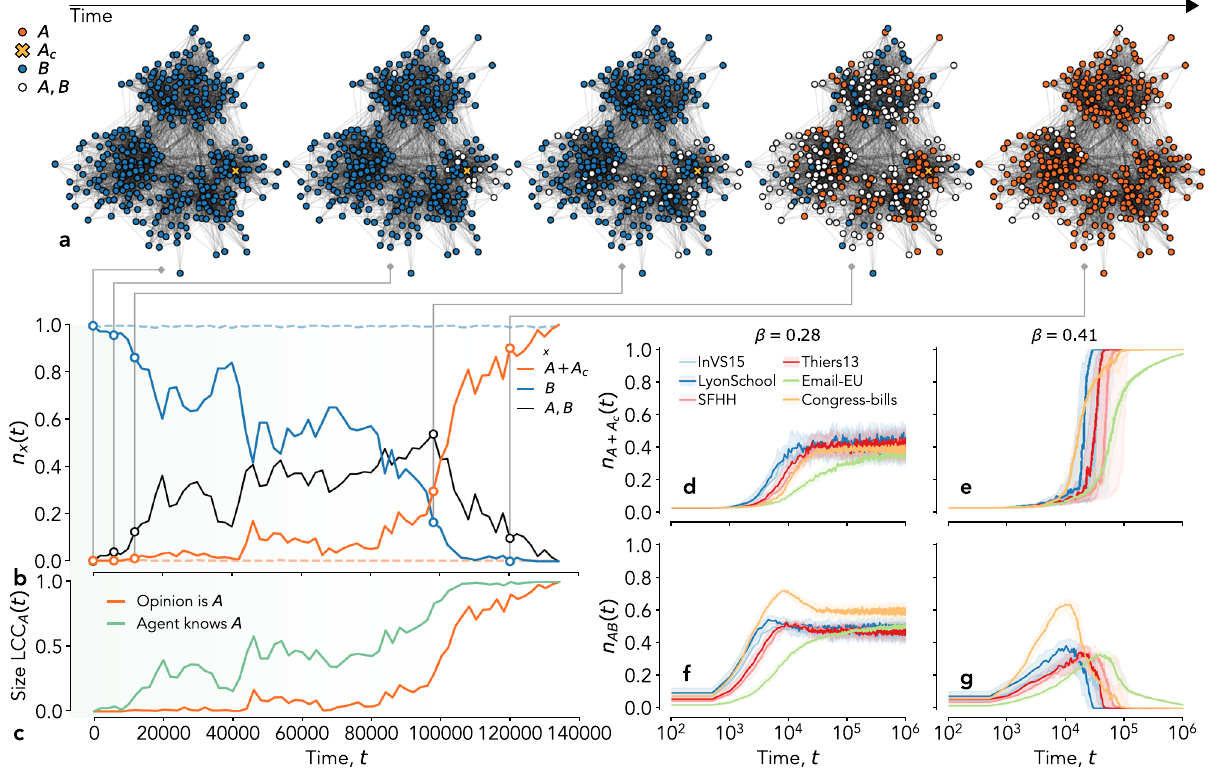
Fig. 2 Critical mass dynamics. a Illustrative example of a simulation of the Naming Game (NG) with unanimity rule on an empirical social structure (Thiers13), where a minority A c of one single committed individual supporting A --consisting of 0.3% of the population of 327 individuals--overturns the stable social norms and reaches global consensus (under imperfect communication, with social in fl uence parameter β = 0.336). b Temporal evolution of the fraction n x ( t ) of nodes supporting name x . Different solid lines correspond to different names, x = { A + A c , B , ( A , B )}. Dashed lines are reported as a benchmark, representing the case with perfect communication ( β = 1). c Temporal evolution of the normalised size of the largest connected component (LCC) of nodes supporting name A (red curve) and nodes that have A (but not necessarily A only) in their vocabulary (green curve). Panels d, e, f, g show the temporal evolution of the dynamics with committed minorities ( p = 3%) on empirical higher-order structures. The social structures are constructed from empirical data sets collected in six different context: a workplace (InVS15) 84 , a primary school (LyonSchool) 85 , a conference (SFHH) 86 , a high school (Thiers13) 58 , email communications (Email-EU) 87 and a political congress (Congress-bills) 88 . The temporal evolution of the densities of nodes holding name A and holding both A and B are reported in panels ( d, e ) and ( f, g ), respectively, for two different values of the parameter β quantifying the ef fi cacy of reaching an agreement within a group, namely β = 0.28 ( d, f ) and β = 0.41 ( e, g ). The results over different runs of stochastic simulations are reported as median values (solid lines) and values contained within the 25th and 75th percentiles (shaded values of β . Figure 2d – g shows the results averaged across 50 different runs for each empirical structure. In each panel, the fraction of nodes supporting name x is plotted as a function of time [panels (d,e) x = A + A c , panels (f,g) x = ( A , B )] for two